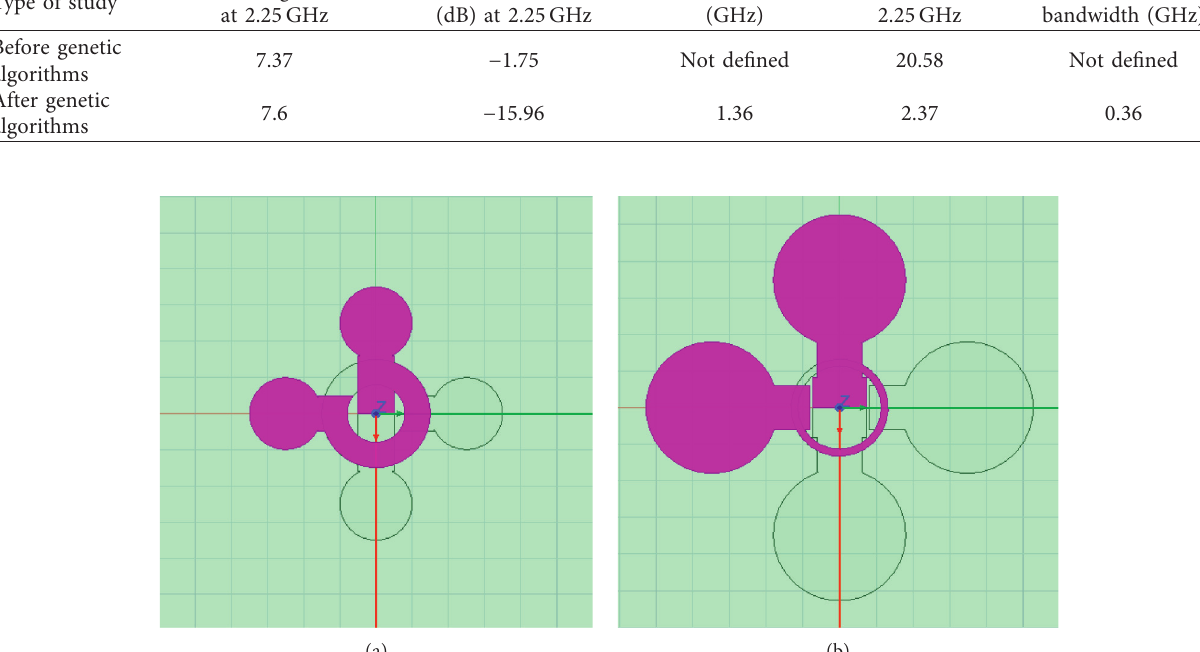
Figure 3: Antenna geometries: (a) before and (b) after optimization.